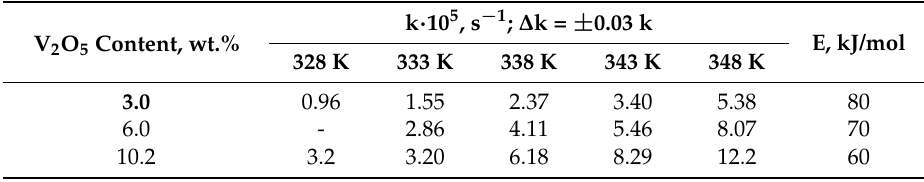
Table 4. The rate constants of thermolysis of BP in styrene in the presence of V 2 O 5 . Concentration of peroxide groups—0.03